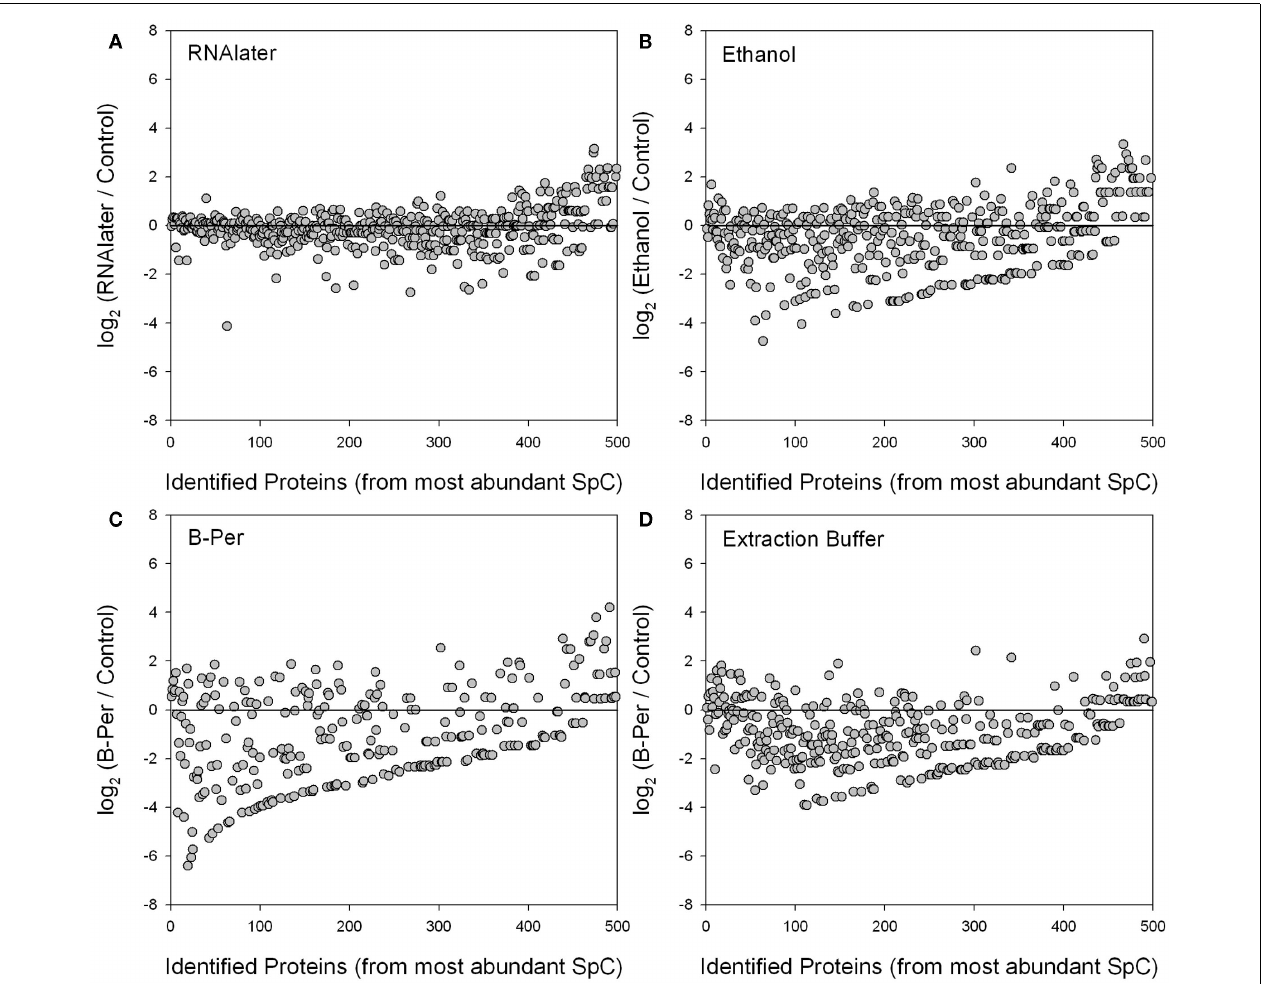
of spectra within each sample, and weighting across samples (including replicates).The RNA later treatment (A) showed the least degradation relative to the control, and perhaps even shows a higher relative abundance of rarer proteins in the RNA later sample (far right). Ethanol (B) and SDS-extraction buffer (D) showed good recovery of the most abundant proteins, but degradation of many of the less abundant ones.The B-PER treatment (C) showed degradation throughout including the most abundant proteins.The upward-sloping line of data points in the bottom of (B–D) were caused by a combination of the abundance ordering on the horizontal axes and the low spectral counts of degraded proteins in the preserved treatment.